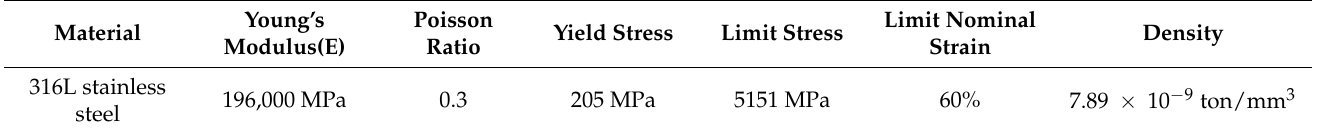
Table 1. Mechanical properties of the constituent material of the stent for FEA simulation.